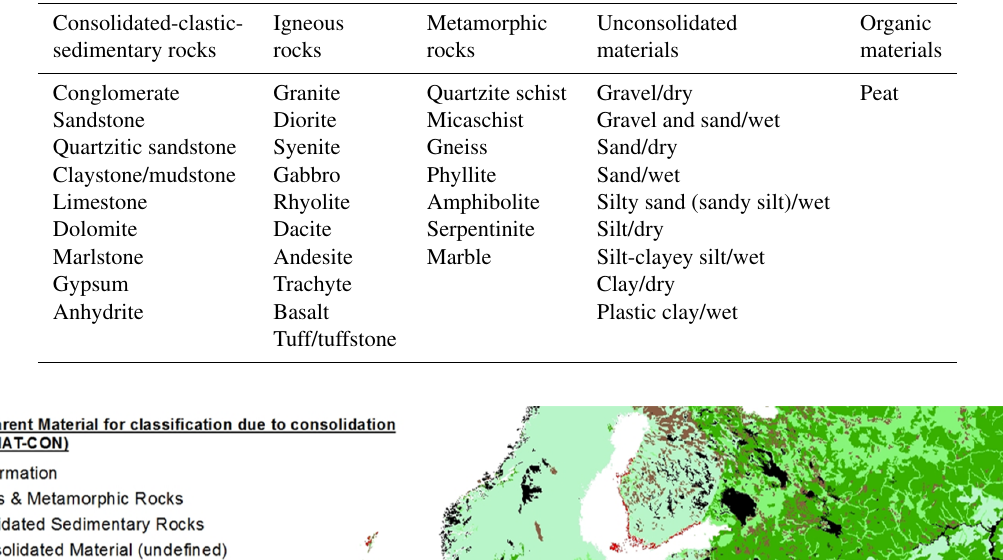
Table 1. Reference list of material in the Thermo-Geological database (Galgaro et al., 2019).